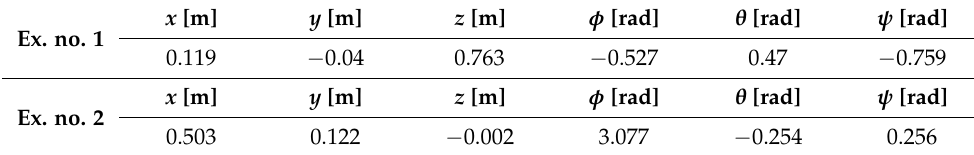
Table 4. Examples.